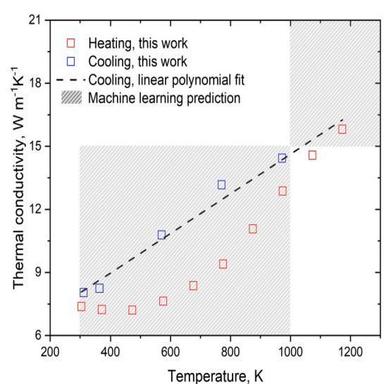
Measured thermal conductivity of annealed UFe3B2 sample and predictions by the machine learning model.